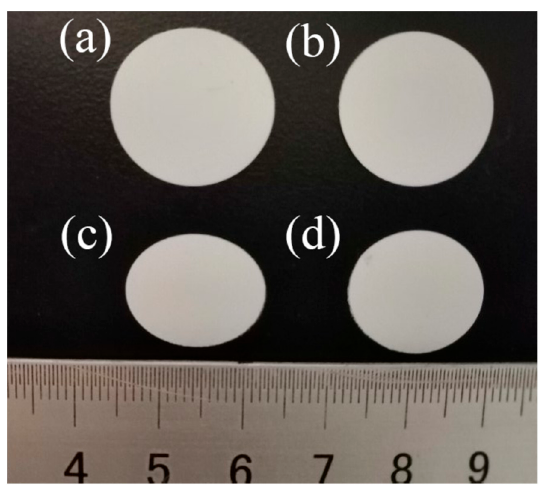
Figure 4. Digital camera images of ( a , b ) bare PE and PE-PVDF separator at room temperature (25 °C); ( c , d ) bare PE separator and PE-PVDF separators (140 °C/30 min).